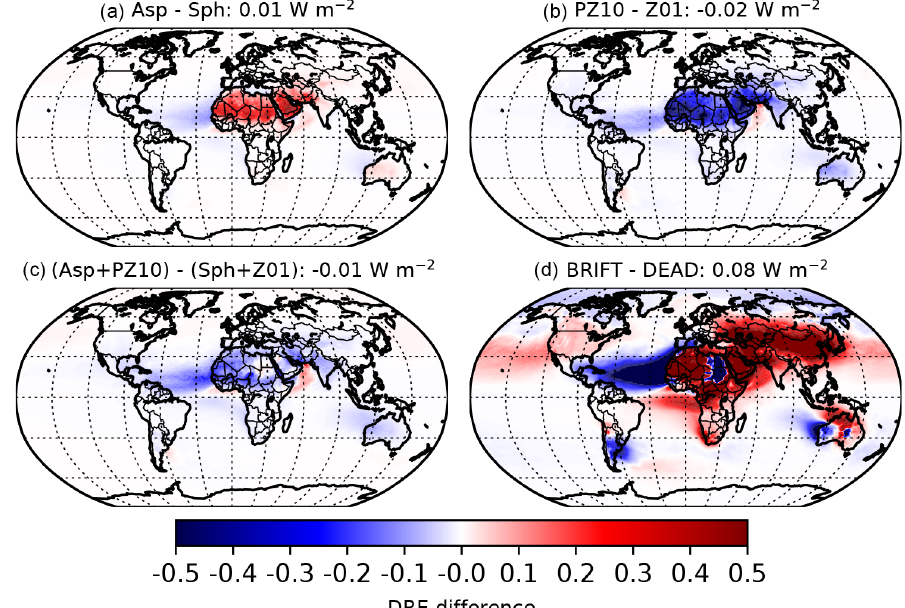
Figure 10. Spatial distribution of the net (shortwave plus longwave) direct radiative effect (DRE) difference (unit: Wm − 2 ) at the top of the atmosphere under all-sky conditions in current climate between model results using non-spherical (asp) and aspherical dust (sph) (a) , PZ10 and Z01 (b) , Asp + PZ10 and Sph + Z01 (c) , and BRIFT and DEAD (d) . The longwave DRE was augmented by 51% to account for the dust scattering. Numbers shown in each panel title represent annual mean difference in global